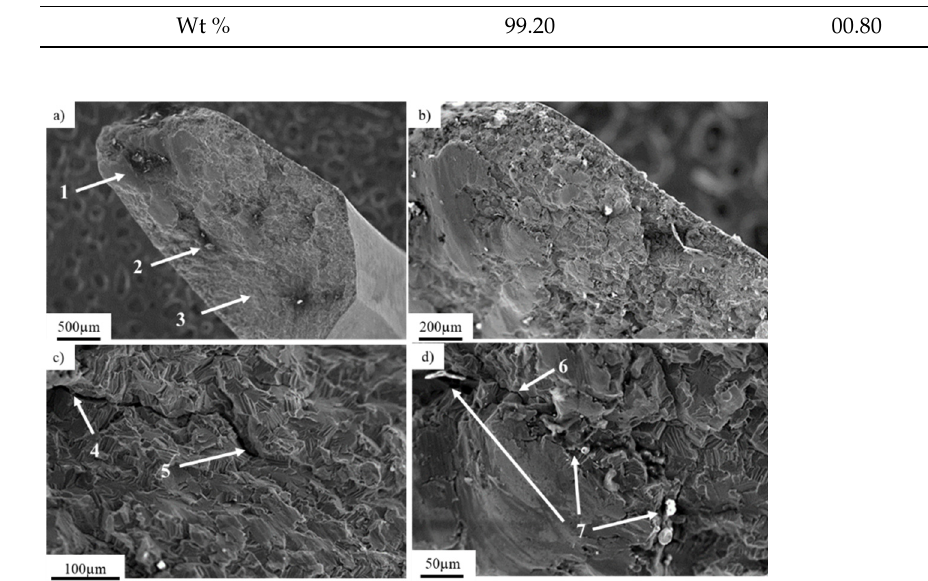
Figure 2. Fracture area of the titanium implant with marked fracture zones ( a ; 1–3) and its magnification showing the fatigue crack propagation zone ( b ); the crack development observed on titanium explant ( c ; 4–5) and its magnification showing the fatigue crack propagation area ( d ; 6) with local inclusions ( d ; 7).